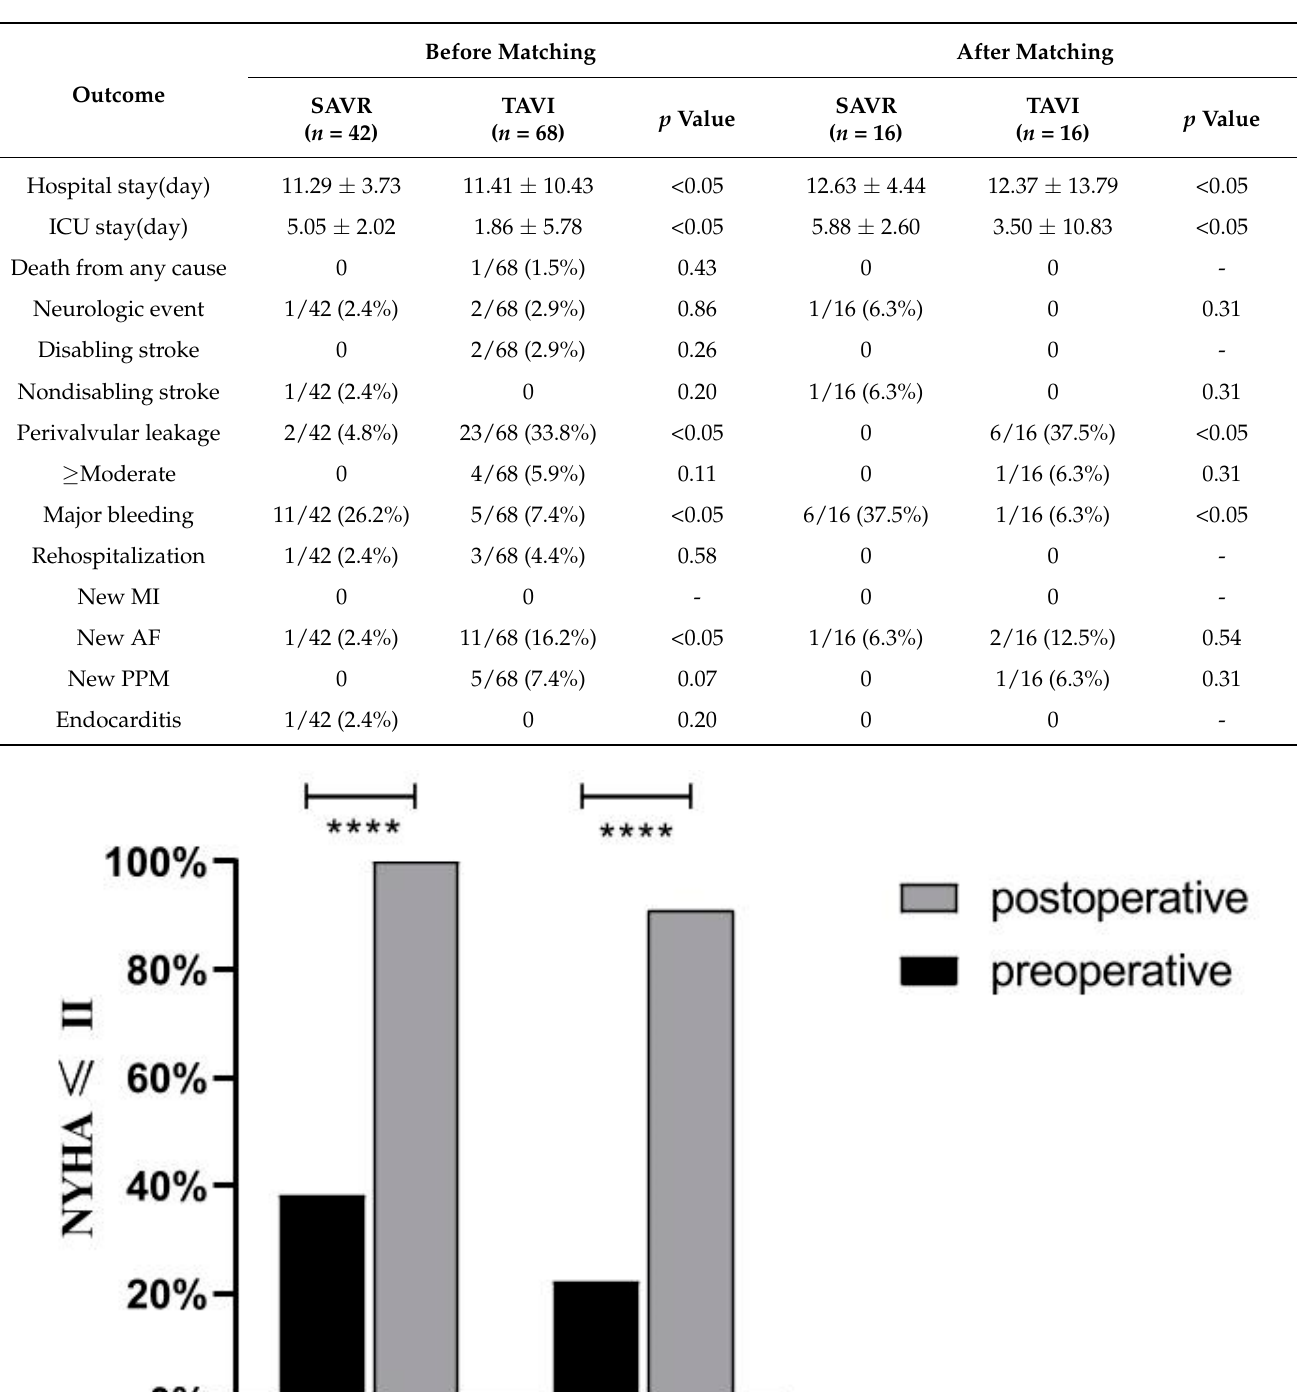
Table 2. Comparison of postoperative and 30-day follow-up results between the two groups before and after propensity score matching. ICU, intensive care unit; AF, atrial fibrillation; PPM, permanent pacemaker.